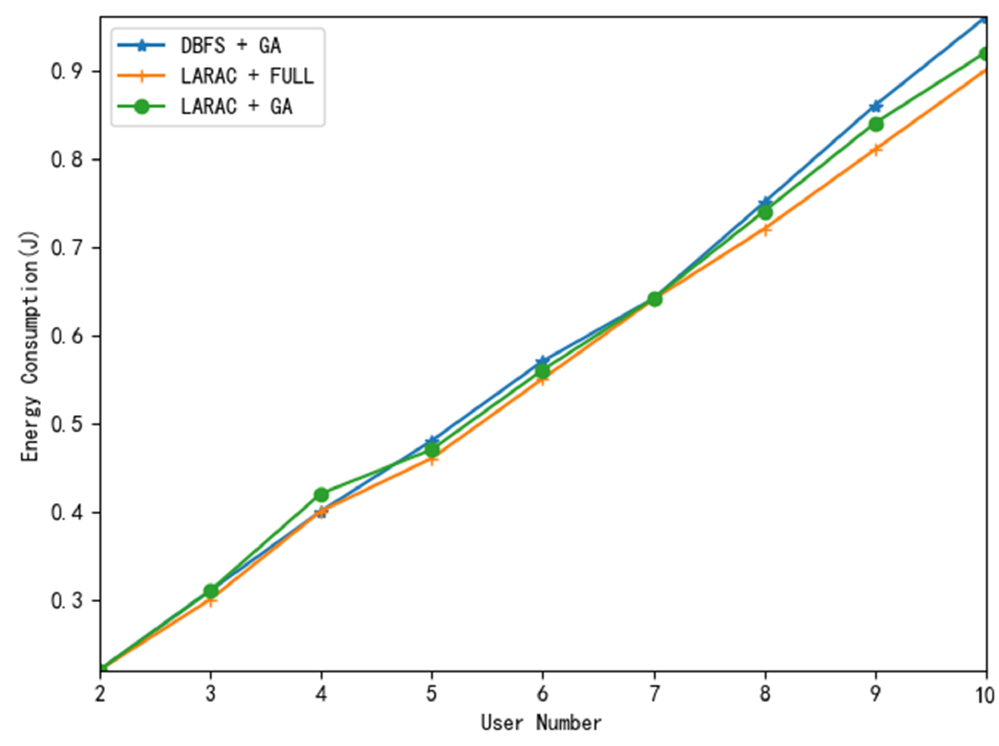
Figure 5. User number vs. energy